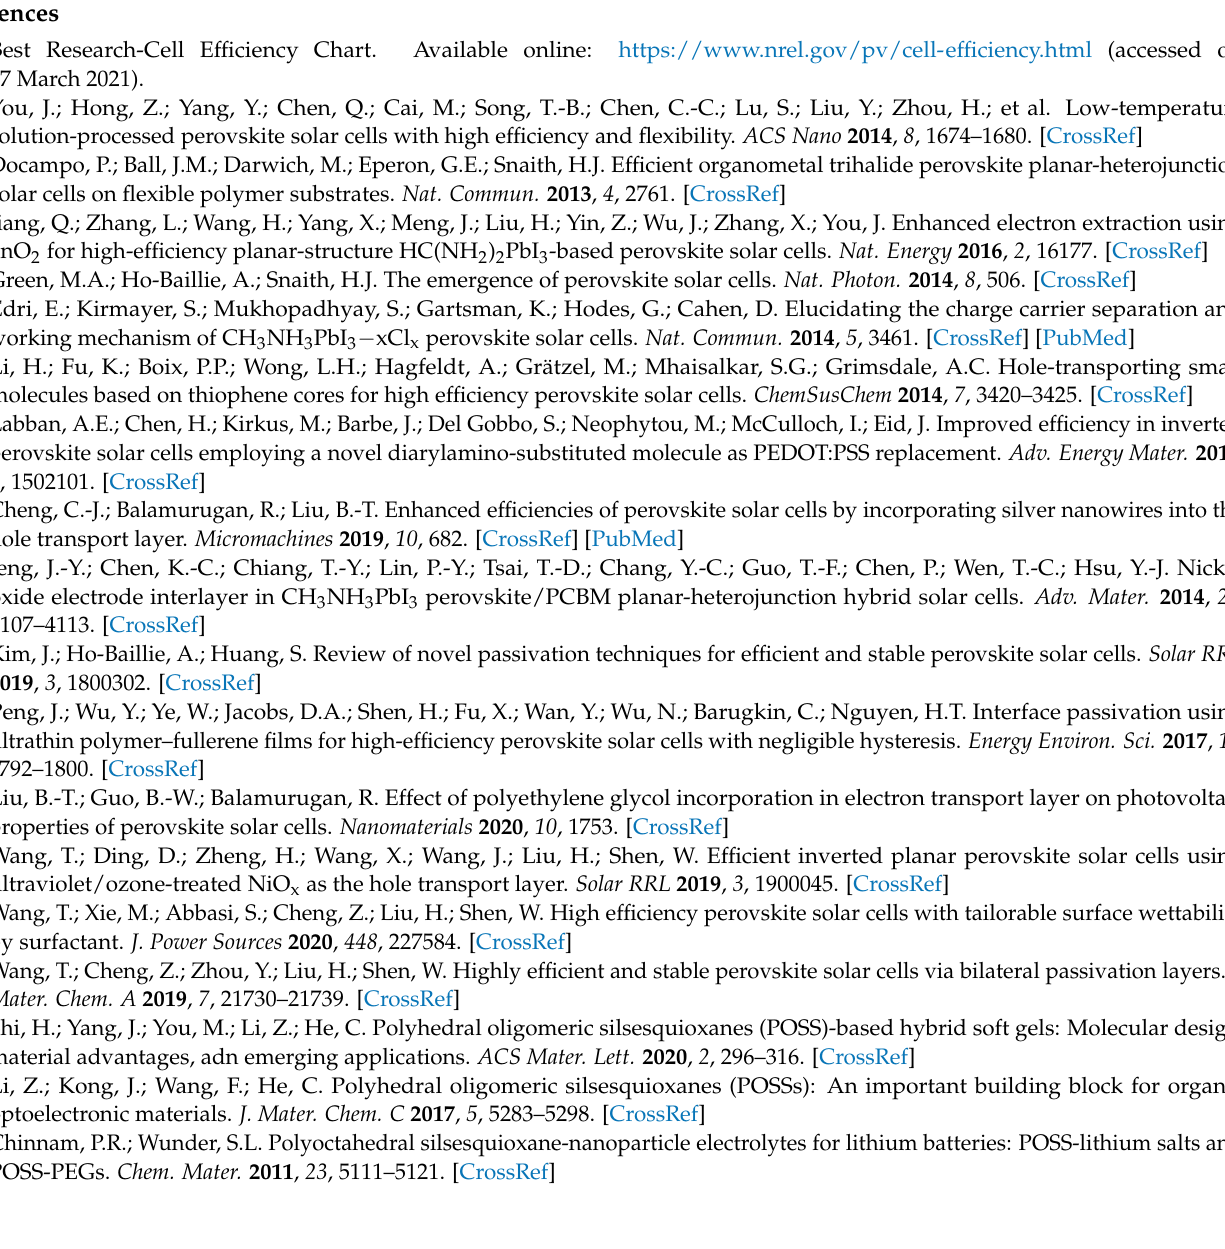
Figure S2: Average grain sizes of the MAPbI3 layers over various FTO/NiOX/POSS substrates, Figure S3: AFM topography images of the FTO/NiOX/POSS with various POSS contents; Figure S4: Dark current-voltage curves of the control cell and the champion